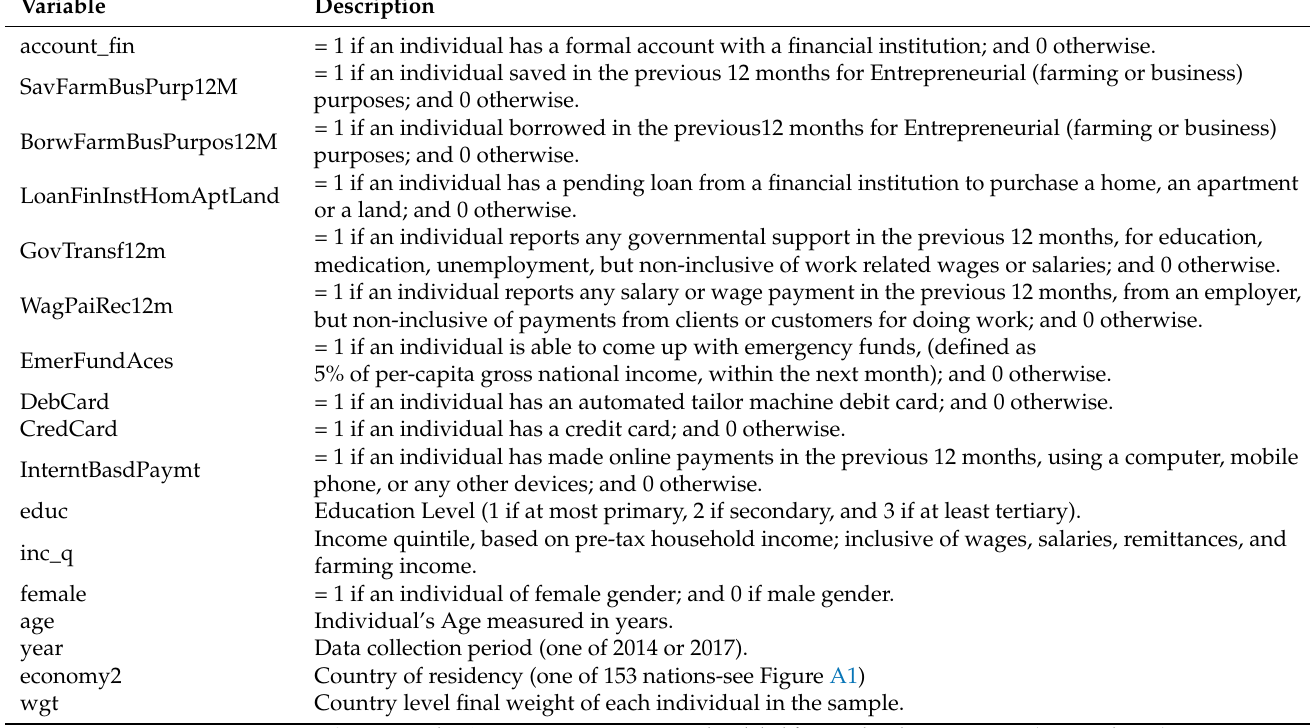
Table A1. Study variables